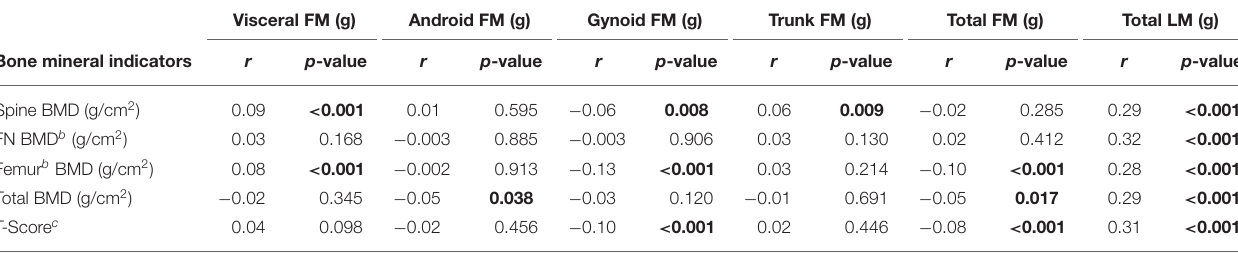
TABLE 3 | Partial correlation between bone mineral indicators and body composition variables a . Visceral FM (g)